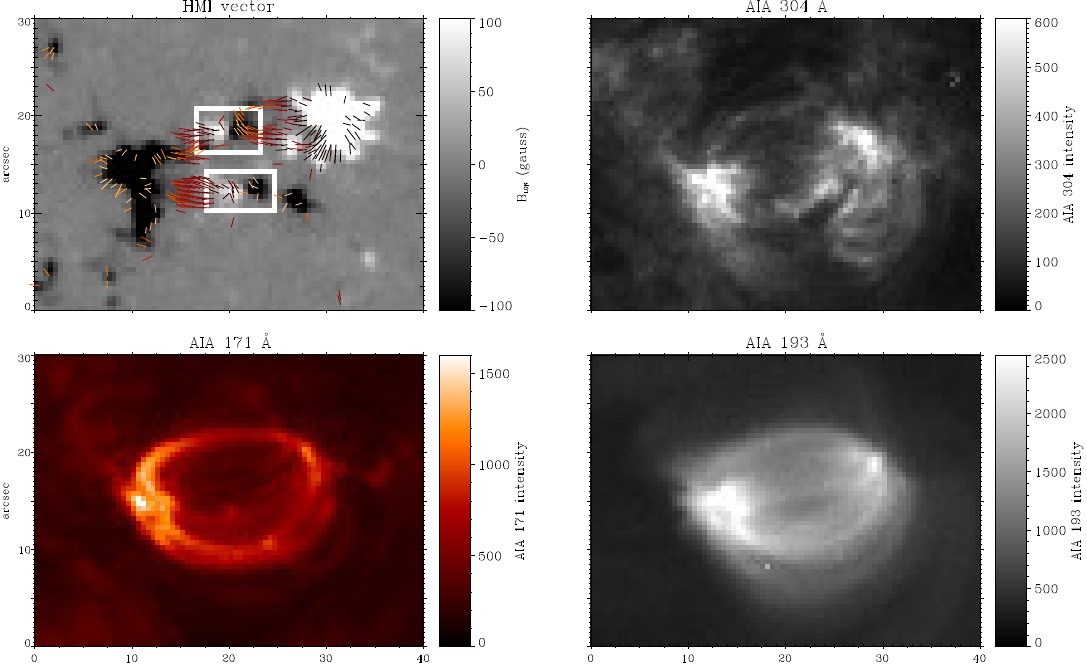
Figure 2: Observations of an emerging flux region by SDO/HMI and SDO/AIA. Images from AIA show the response of the corona to the birth of an active region at the solar surface. Image reproduced with permission from Centeno (2012), copyright by